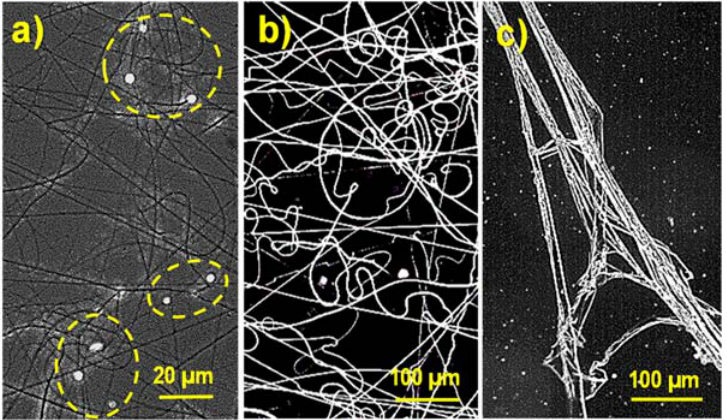
Figure 1. Optical micrographs comparing the morphology of γ -PGA electrospun fibers obtained at concentrations of 3 ( a ), 8 ( b ) and 13 wt-% ( c ) using a voltage of 30 kV, a flow rate of 1 mL/h and a needle to collector distance of 25 cm.